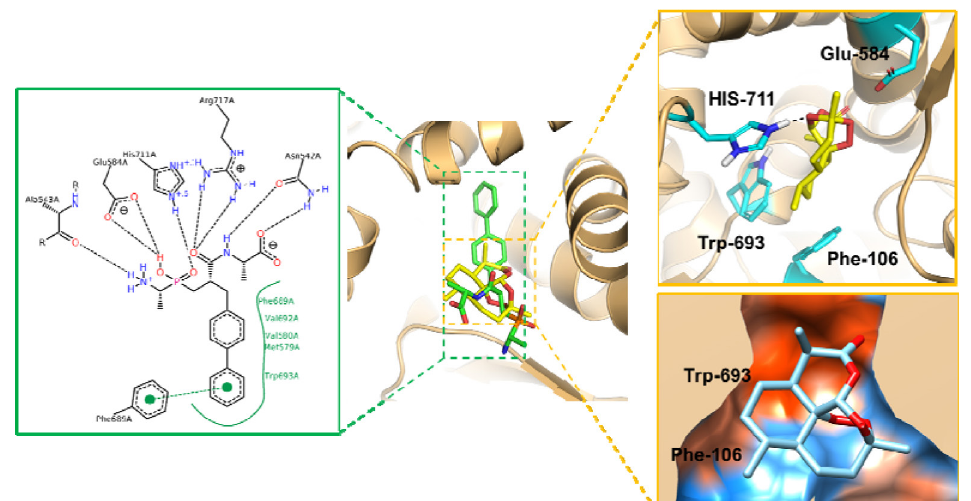
FIGURE 5 - Comparison of the putative binding mode of arteannuin (yellow) and the experimental BIR ligand-binding mode observed in the co-crystal structure (green; PDB code 1R1H). The receptor is shown in light orange cartoon representation. Black dashed lines indicate hydrogen bonds. The green solid line represents hydrophobic interactions and green dashed lines show π-π interactions. Hydrophobic and hydrophilic residues are represented by orange red surface and dodger blue surface, respectively (in right bottom